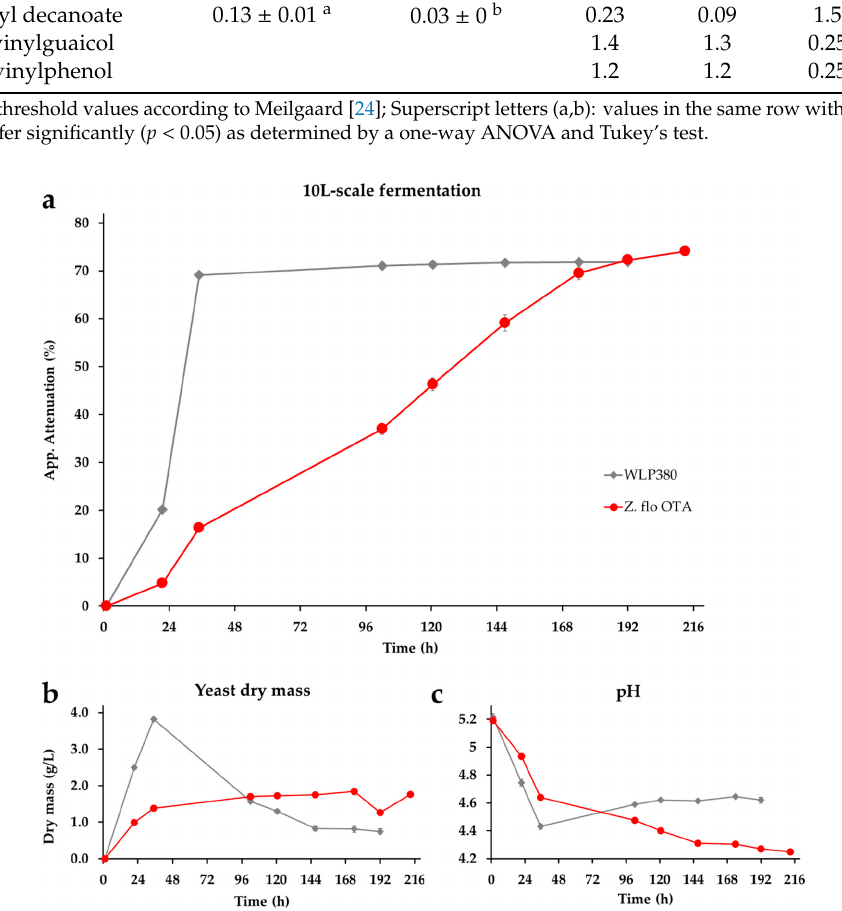
Figure 3. Fermentation characteristics of the Z. florentina strain Z. flo OTA and the reference ale yeast strain WLP380 in regard to ( a ) apparent attenuation, ( b ) dry mass and ( c ) pH. Original strength of the wort was 12 °P and the fermentations were conducted at 20 °C. Error bars—when visible—represent the range between the duplicates.